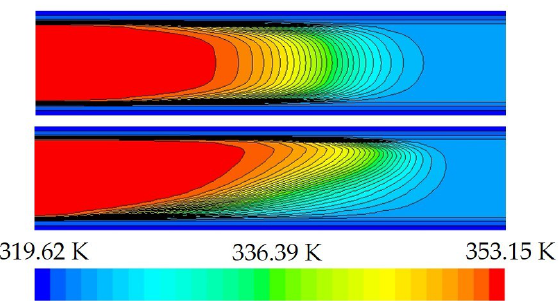
Figure 27. Effect of gravity on the temperature distribution of a hot wave (the upper part shows the temperature front without effects of gravity, the lower part shows the contrary).